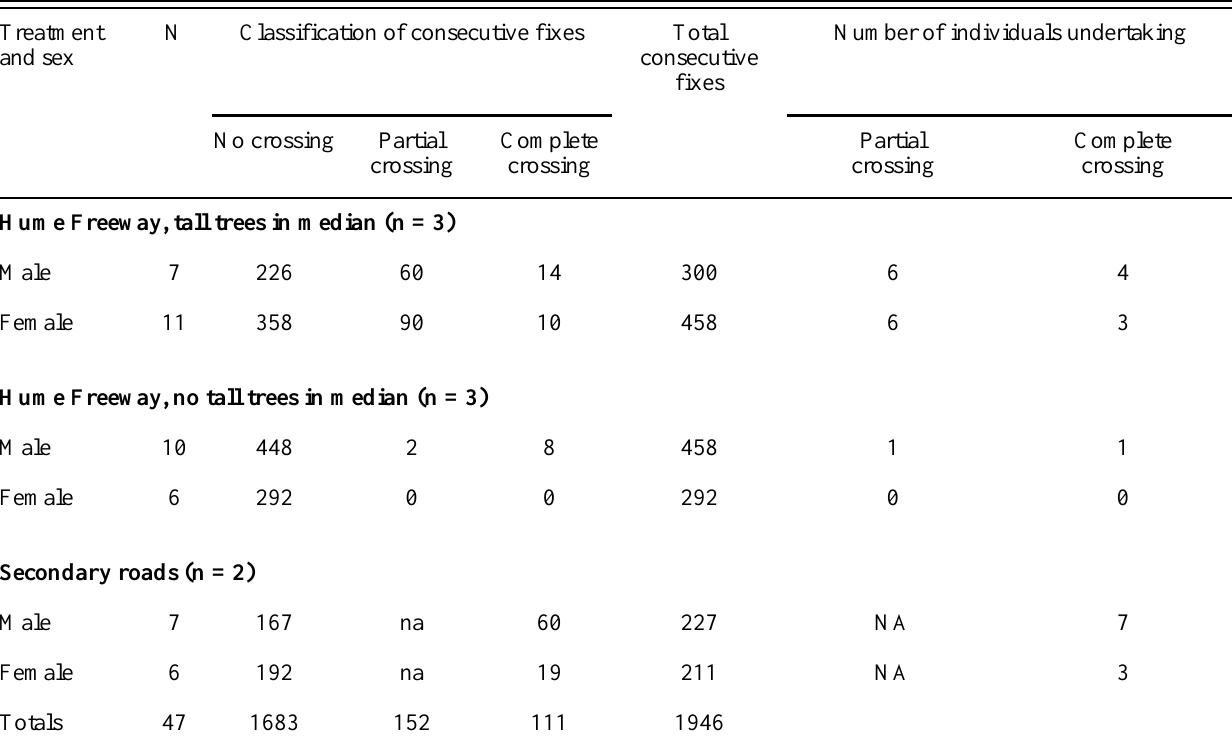
Table 2. Classification of consecutive fixes of 47 squirrel gliders ( Petaurus norfolcensis ) tracked along the Hume Freeway and at secondary roads, southeastern Australia. n, number of individuals; fixes are detections from radio-tracking and trapping, with partial crossings from verge to median or median to verge at the dual-roadway freeway sites and full crossings from one shoulder to the opposite shoulder; total consecutive fixes is total fixes minus the first fix; and number of individuals detected crossing the road.